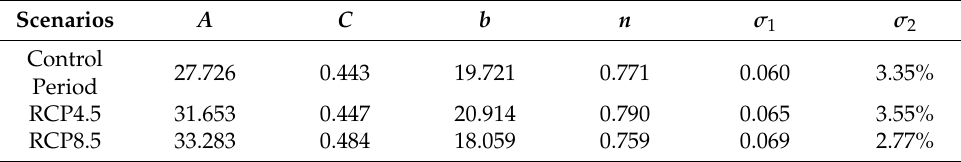
Table 7. The parameter of rainstorm intensity formula.